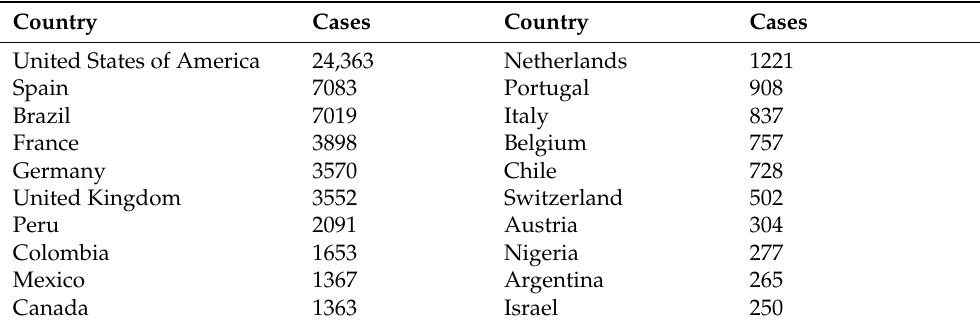
Table 6. Top 20 countries with reported monkeypox cases of the 2022 current outbreak until September 2022 (adapted from